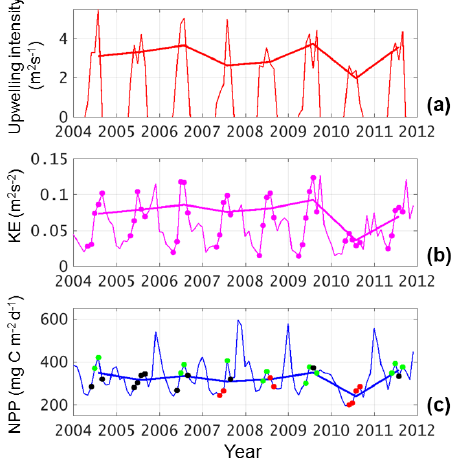
Figure 3. Time series of (a) UI in m 2 s − 1 , (b) KE in m 2 s − 2 , and (c) NPP in mgCm − 2 day − 1 of monthly data (thin lines) and sum- mer mean (thick lines). In panel (a) , only the positive (upwelling- favorable) values are shown. In panel (b) , months with positive UI are marked with dots. In panel (c) , green, black, and red dots in- dicate high NPP anomaly (HNA), normal, and low NPP anomaly (LNA)